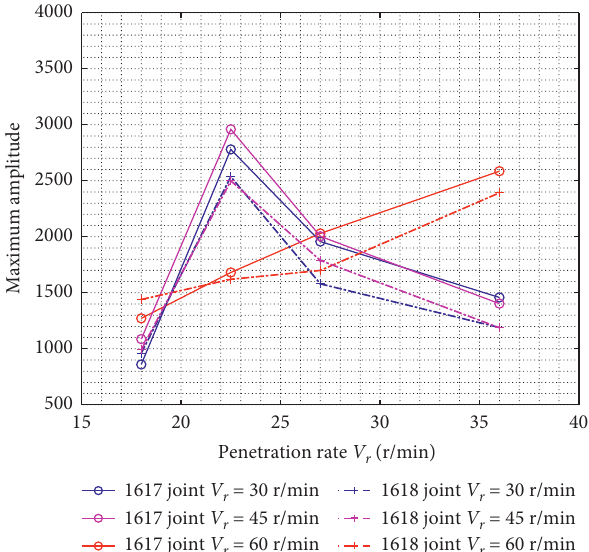
Figure 10: Amplitude spectrum of torque at different penetration rates with a rotation speed of 30r/min and the 1617 joint.